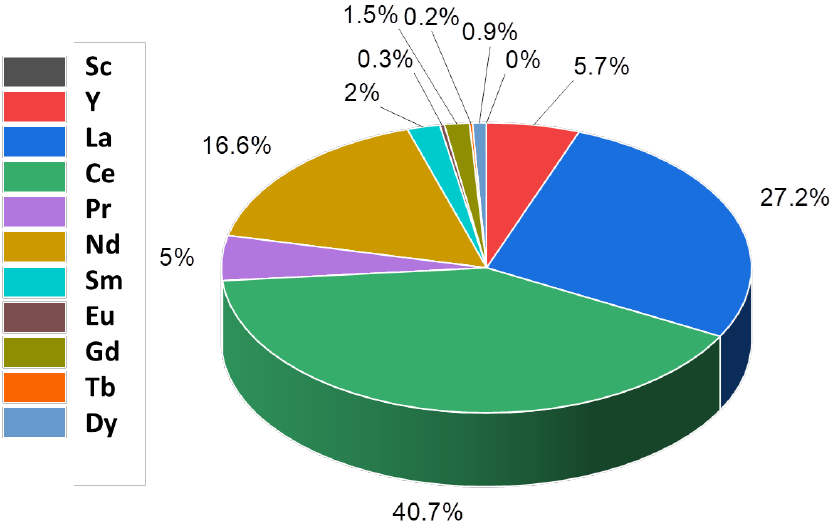
Figure 4. Global distribution of REEs is uneven, resulting in unequal production and balance problems in 2018 [12,13].